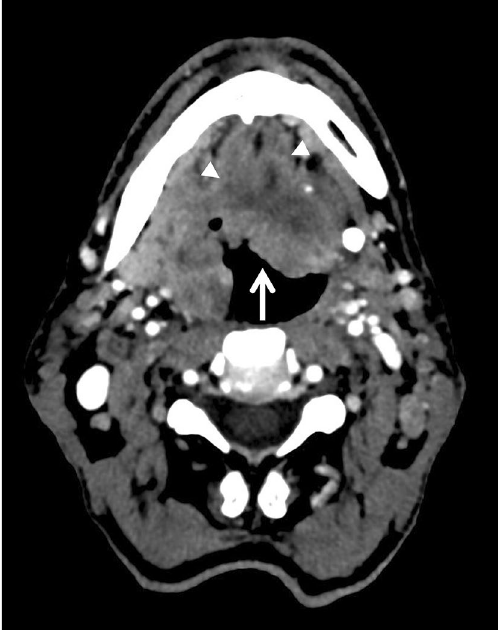
Figure 4. Axial CT slice showing ill-defined contours of a necrotic ulcerated p16− tumour (arrow) of the right palatine tonsil involving the base of the tongue and floor of mouth in a 53-year-old male smoker. Genioglossus muscles were also involved (arrowheads).